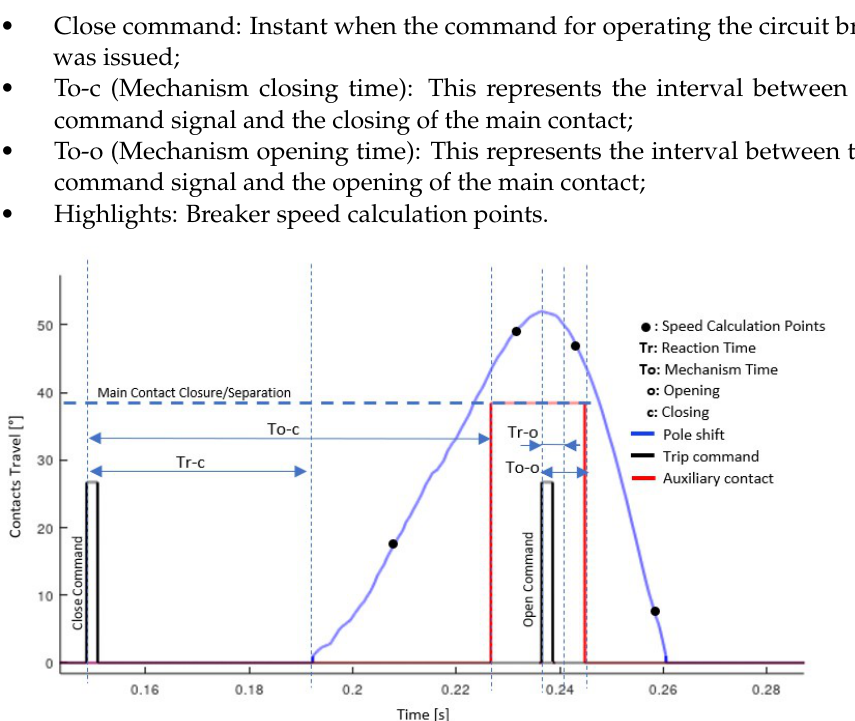
Figure 1. Contact displacement curve for an O-C-O opening–closing maneuver.